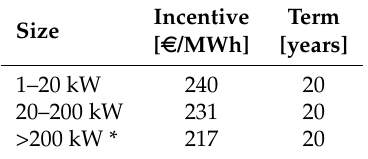
Table 3. Standard tariffs for PV plants using innovative technology established in [63].